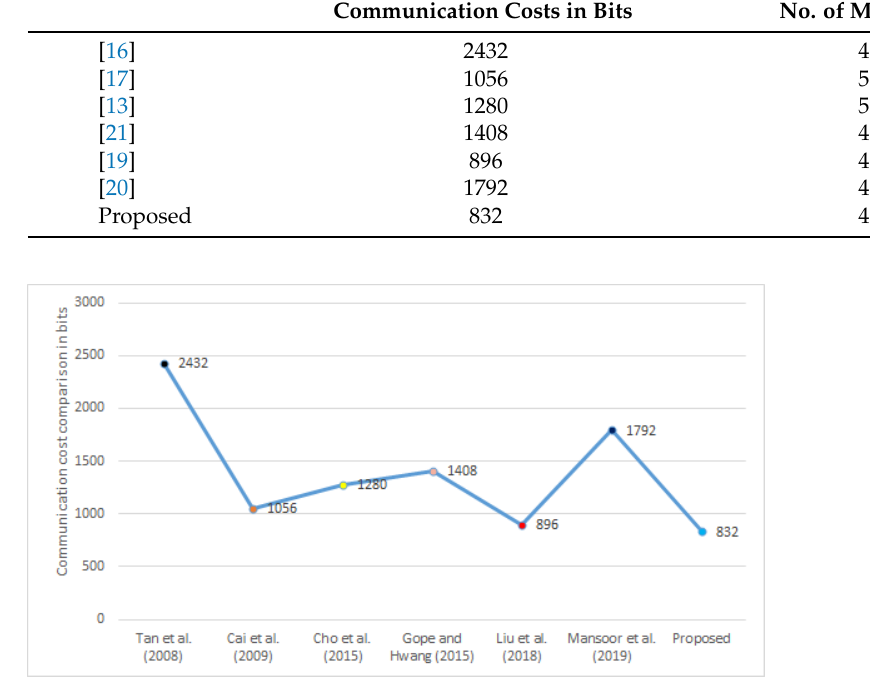
Figure 3. Comparison of the computation